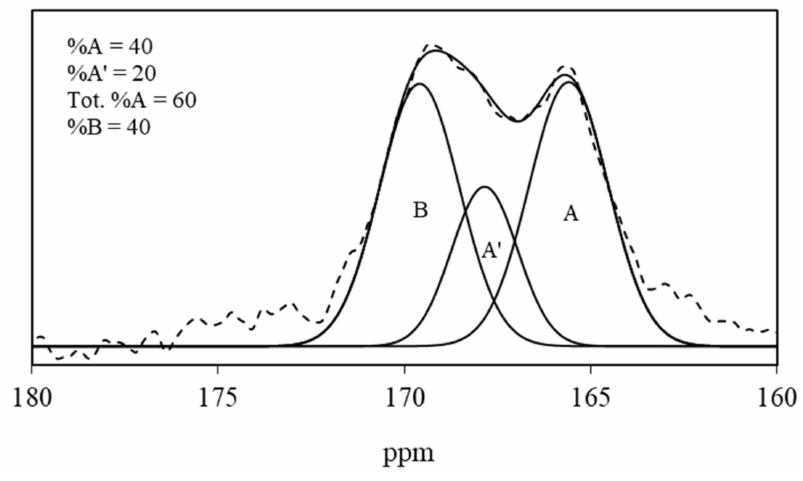
Figure 4. The solid-state MAS 13 C NMR spectrum of